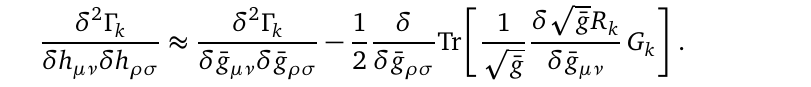
Figure 9: Real part of the relevant critical exponents as a function of N background-field approximation (red continuous line), in the level-one approxima- tion (green dashed line) and for the fluctuation system (blue dot-dashed and light blue dotted